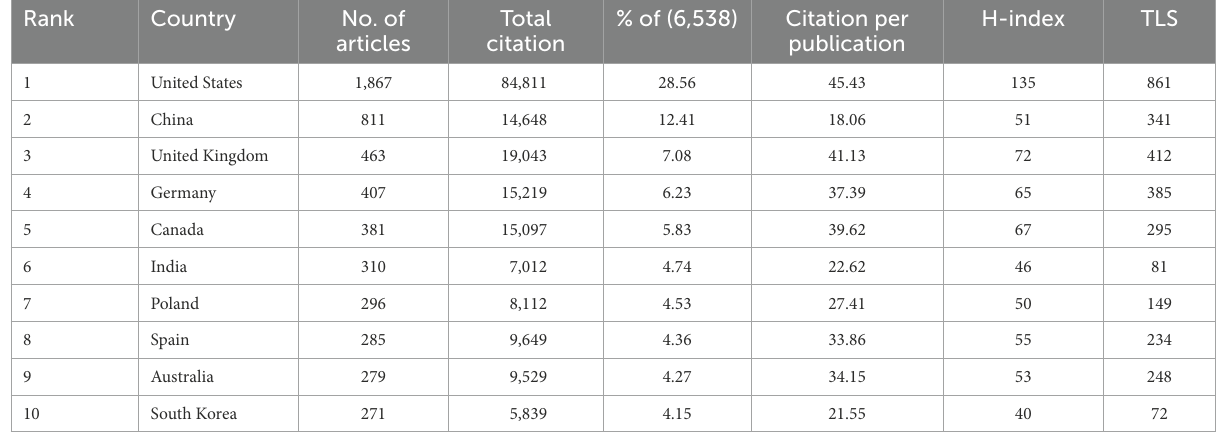
TABLE 1 The top 10 productive countries/regions related to phage therapy in bacterial infection. Rank Country